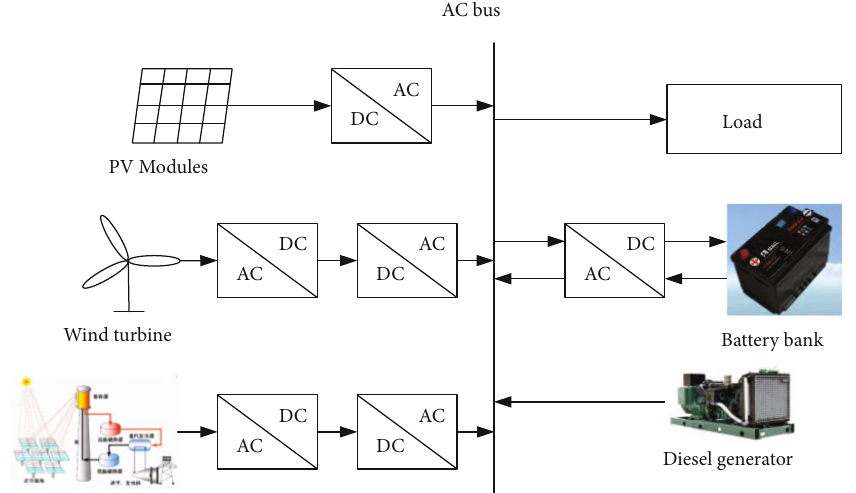
Figure 1: Microgrid